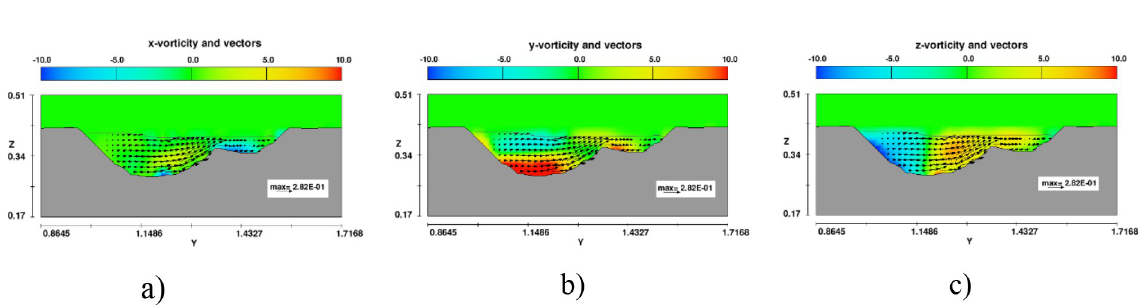
Fig 17. Distribution of vortex components distribution at section 5 in model B. a) x -vorticity; b) y -vorticity; c) z -vorticity.